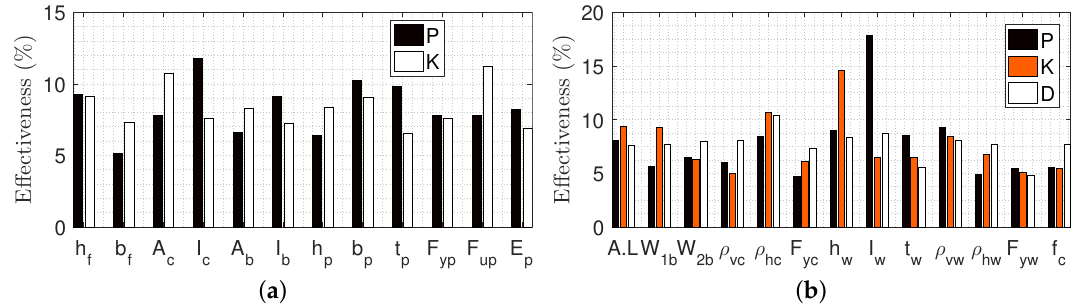
Figure 7. Relative importance of the input parameters in shear wall meta-model. ( a ) SPSW, ( b )